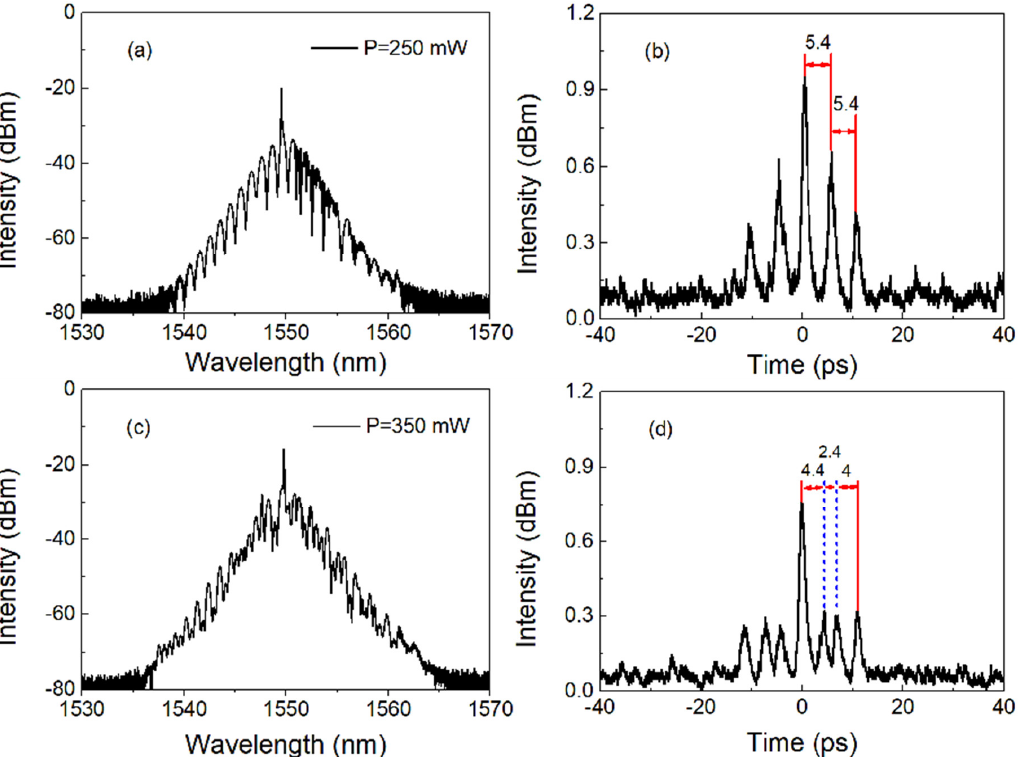
Figure 6. Typical characteristics of three-pulse and four-pulse bound solitons: ( a , c ) optical spectra; ( b , d ) autocorrelation traces.